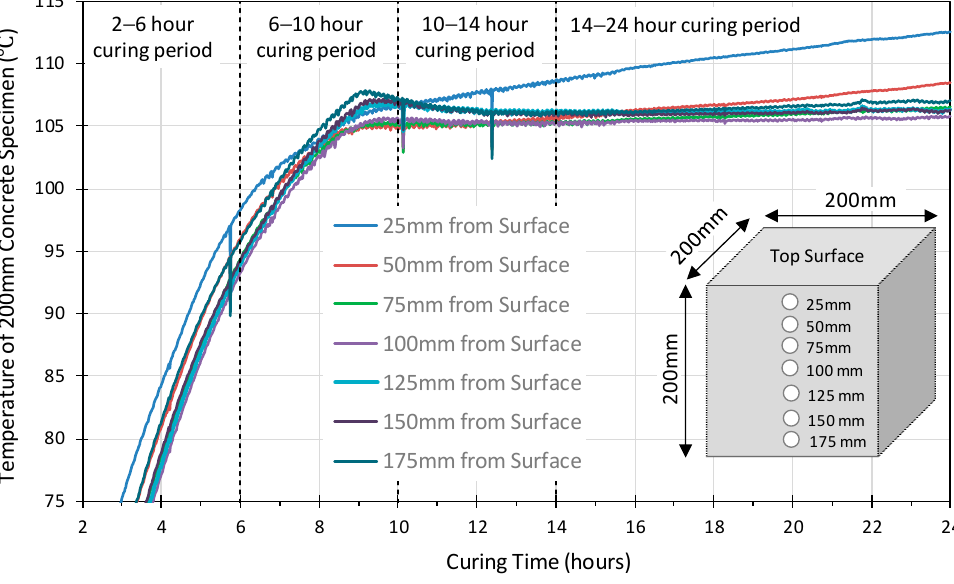
Figure 4. The temperature development versus the depth of 200 mm geopolymer concrete cube.